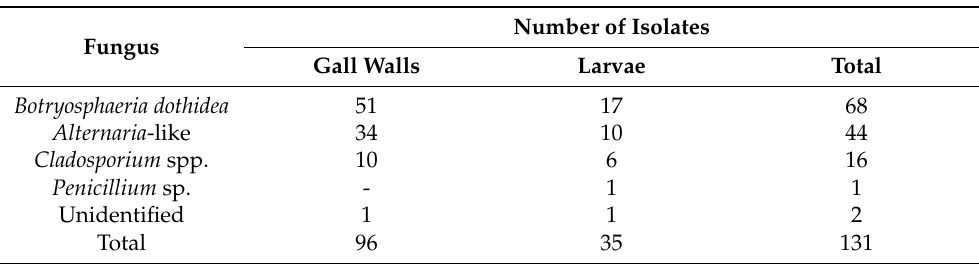
Table 3. Gall-associated fungi isolated from samples collected on Micromeria graeca at the Astroni Nature